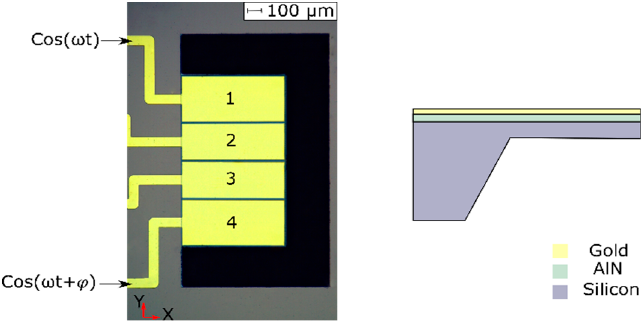
Figure 1. Optical micrograph of the 750 μ m × 1300 μ m cantilever and cross section view along the length of the device, including the suspended part and the silicon anchor. length of the device, including the suspended part and the silicon